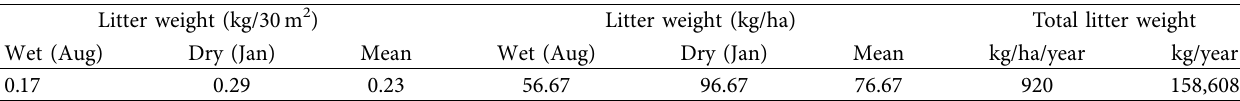
Table 3: Te mean and total weight of litter (BLTs) production from 30m 2 sample plots of eucalyptus plantation during dry (January) and wet (August) seasons/kg/ha and #/year.